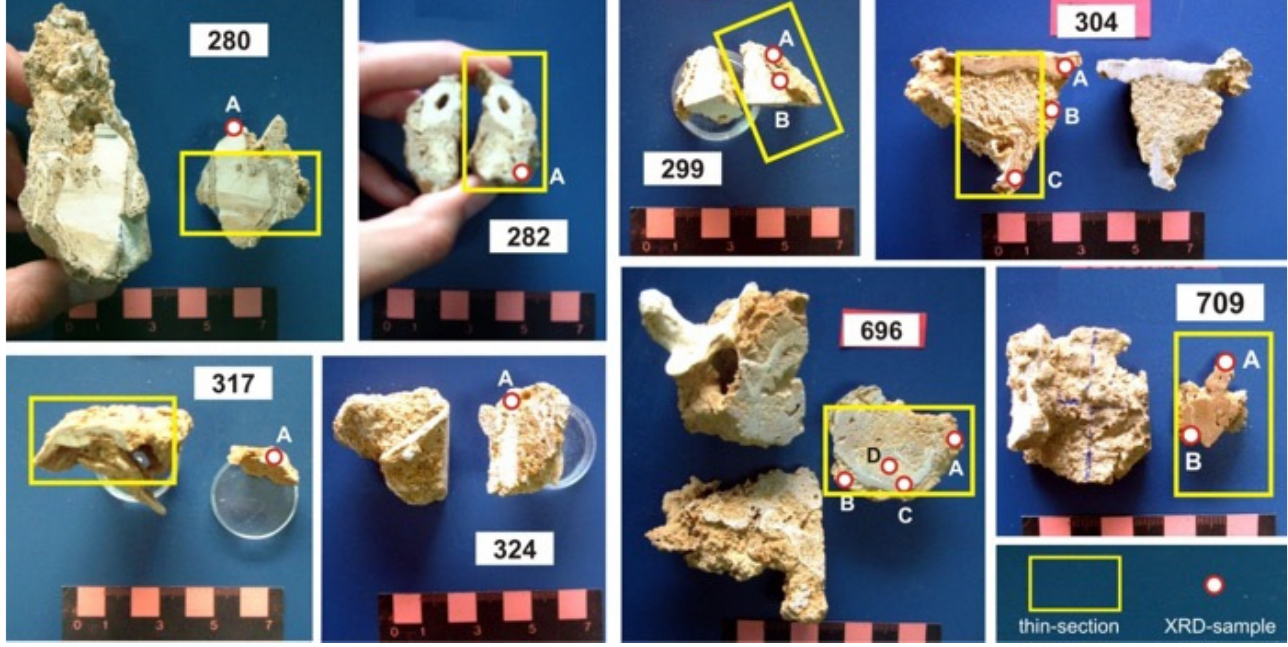
Figure 4. Bone remains with sampled calcareous concretions. The locations of both XRD analyses (dots) and thick sections (yellow rectangles) are given. See table 2 for A, B, C, D.